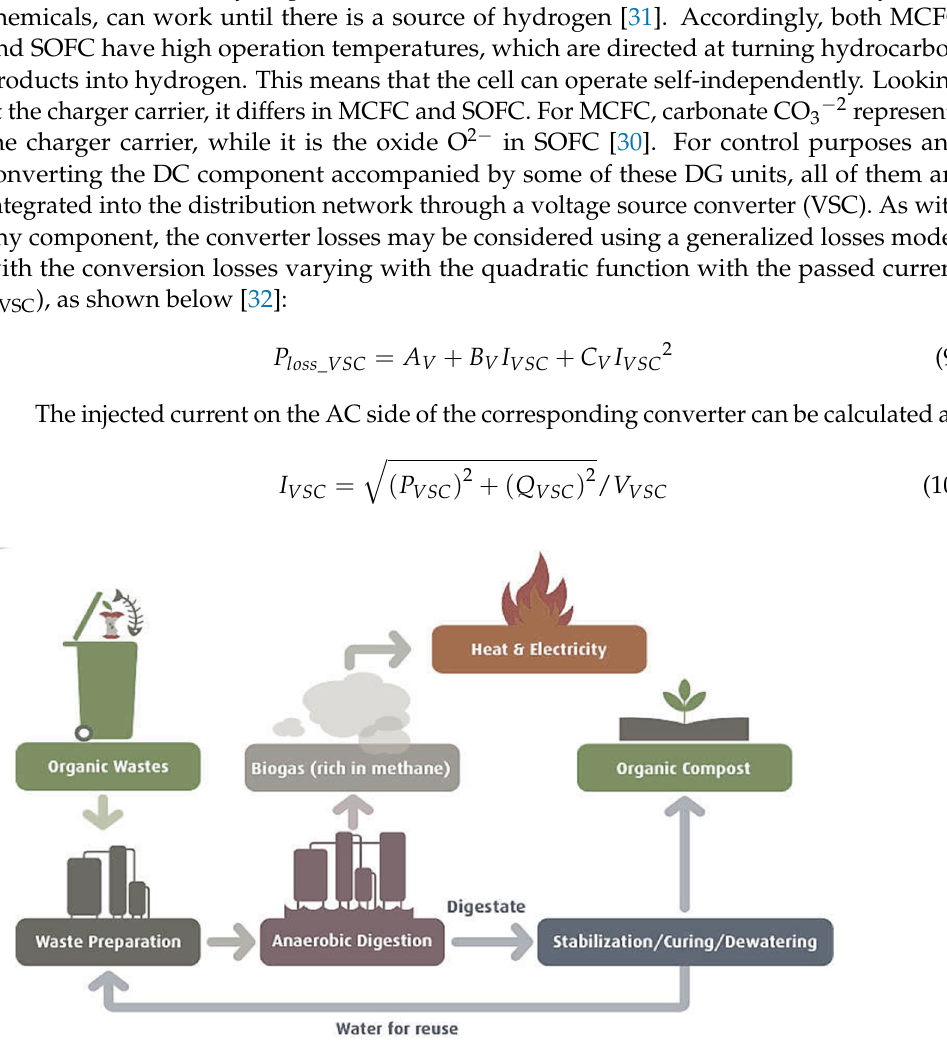
Figure 5. Schematic diagram of Anaerobic Digestion.